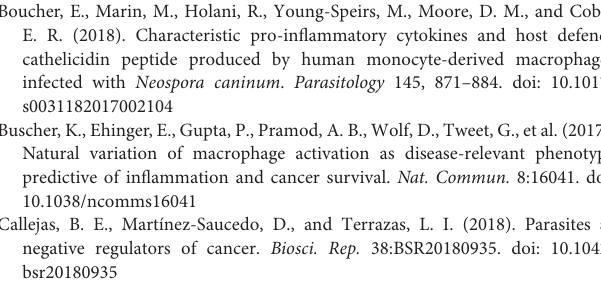
Supplementary Figure 1 | Gating strategy for tumor-associated macrophages. Leukocytes from living cells were labeled with CD45, and macrophages from leukocytes were labeled with F4/80 and CD11b, followed by using MHCII and CD206 to label M1 and M2 macrophages,